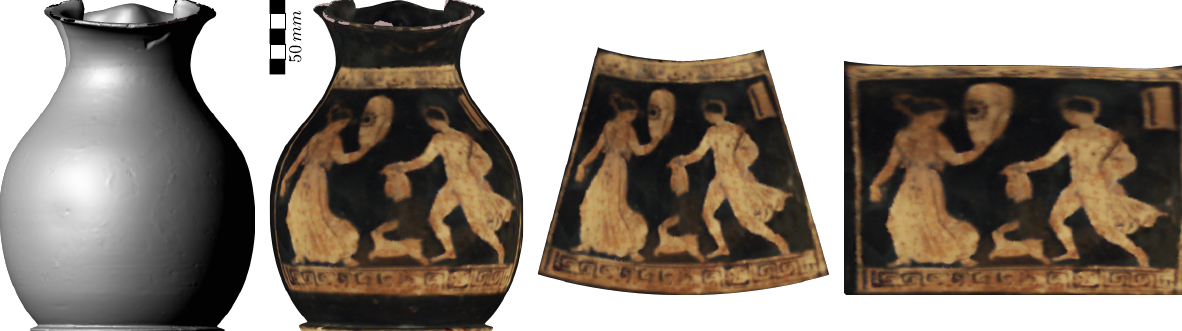
Figure 10: Oinochoe , UMJ Inv.-No. 4181 (Karl et al., 2009). From left to right: A scanned version of the object, an unwrapped variant using a cone, and the result of the equirectangular projection. Unpainted parts of the vessel have been discarded.